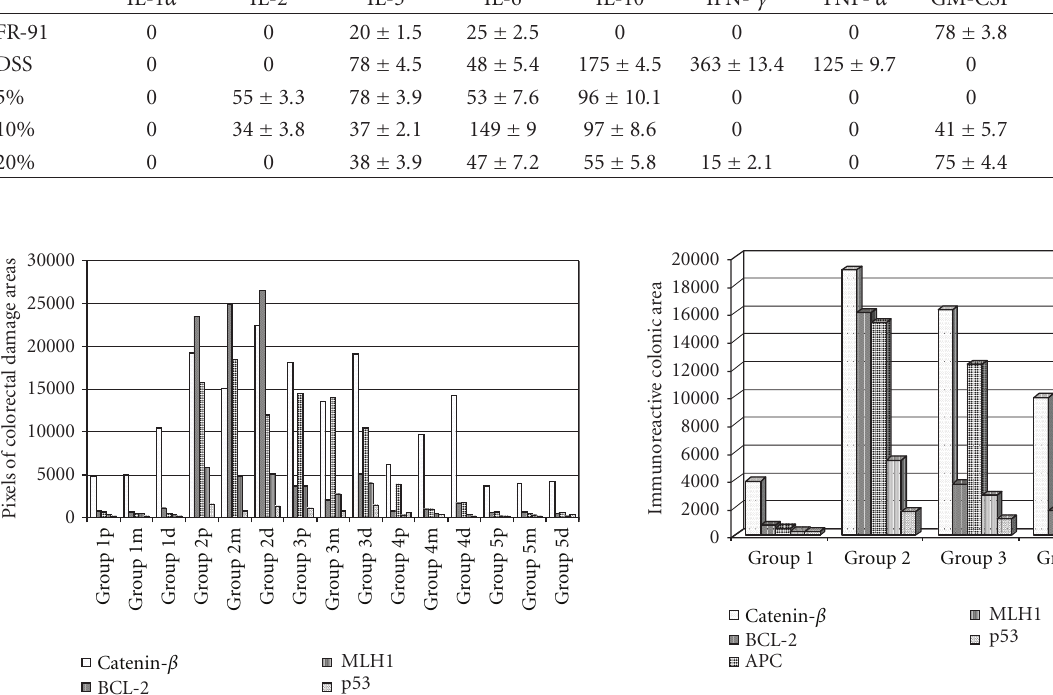
Figure 5: Image analysis of the mean value of colorectal damage area marked by immunoreactivity in mice groups. Group 5 showed a significantly di ff erence ( P < 0 . 05) to the other treatment groups (3 and 4), and a similar mean value when compared with negative control (group